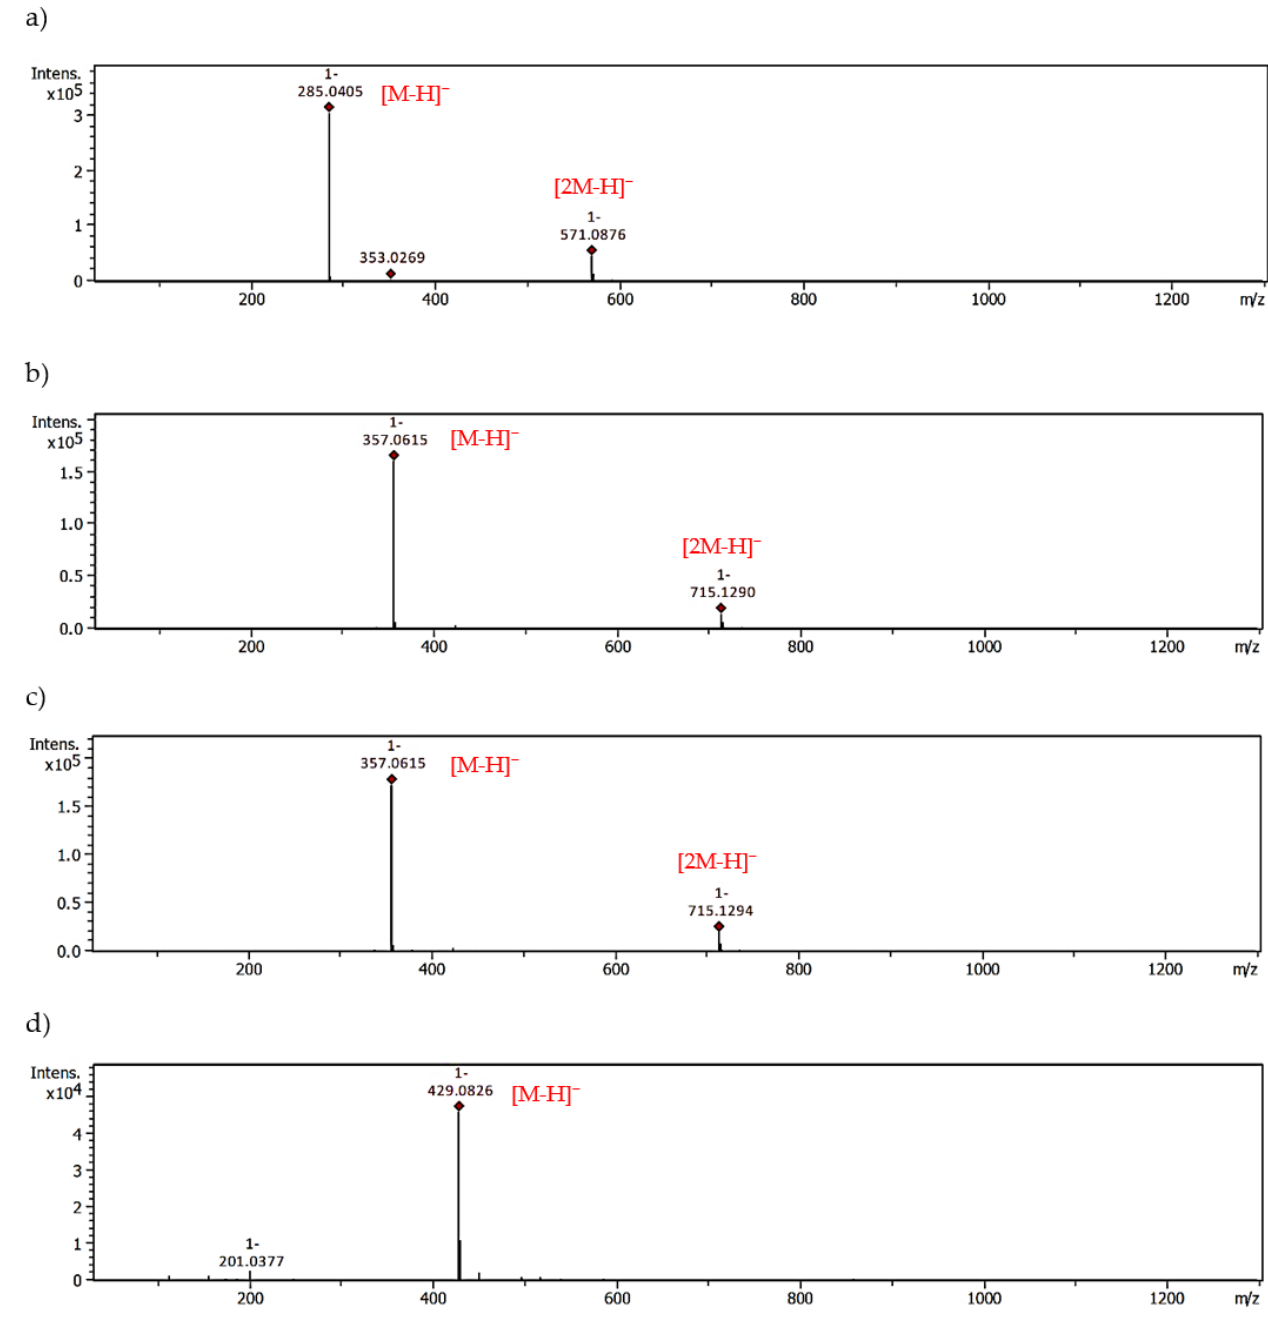
Figure 6. MS spectra of luteolin and luteolin-MGO; ( a ) authentic standard, ( b ) mono-adduct 1, ( c ) mono-adduct 2, ( d ) di-adduct with MGO.